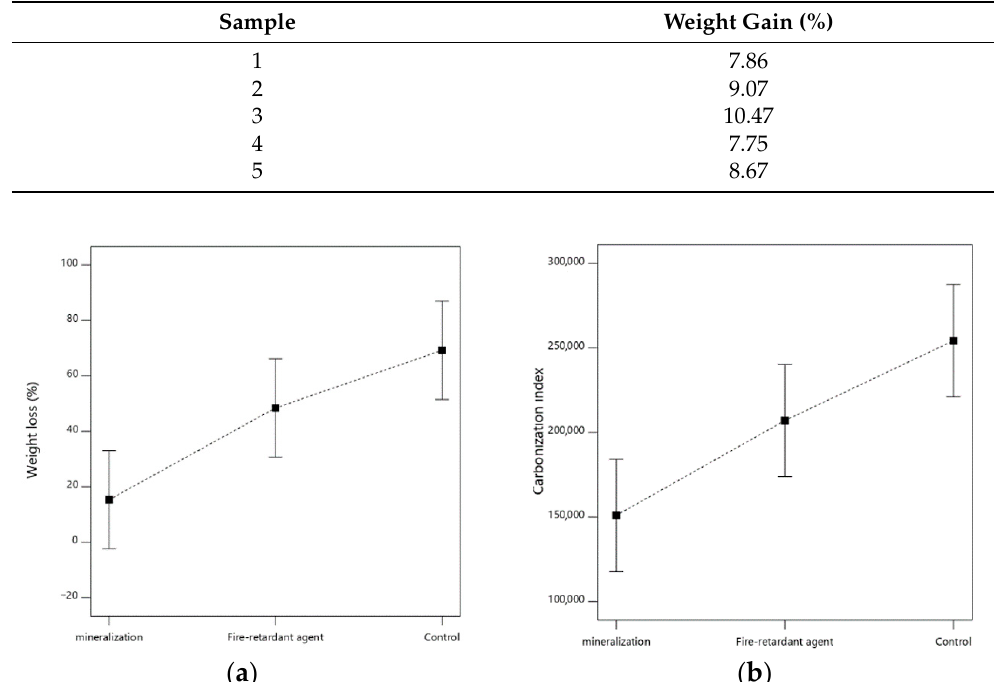
Figure 6. ( a ) Average weight loss and ( b ) carbonization index of mineralized wood samples, samples